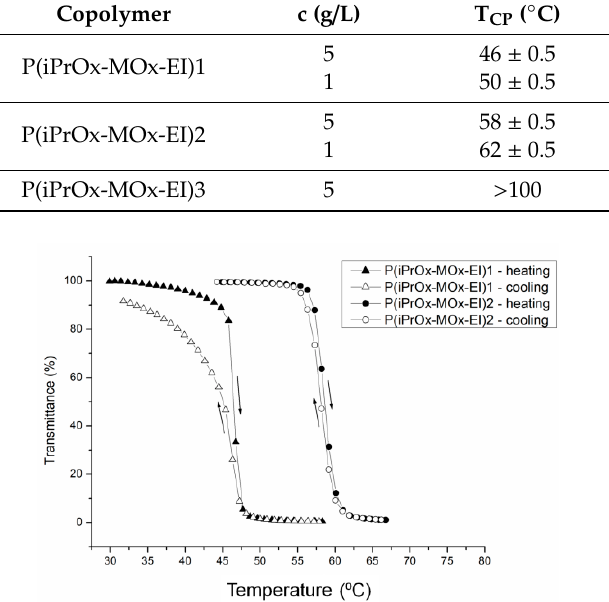
Figure 11. Transmittance-temperature dependence of 5 g/L aqueous solutions of copolymers after hydrolysis . Table 5. T CP values of aqueous solutions of copolymers after hydrolysis at different concentrations.